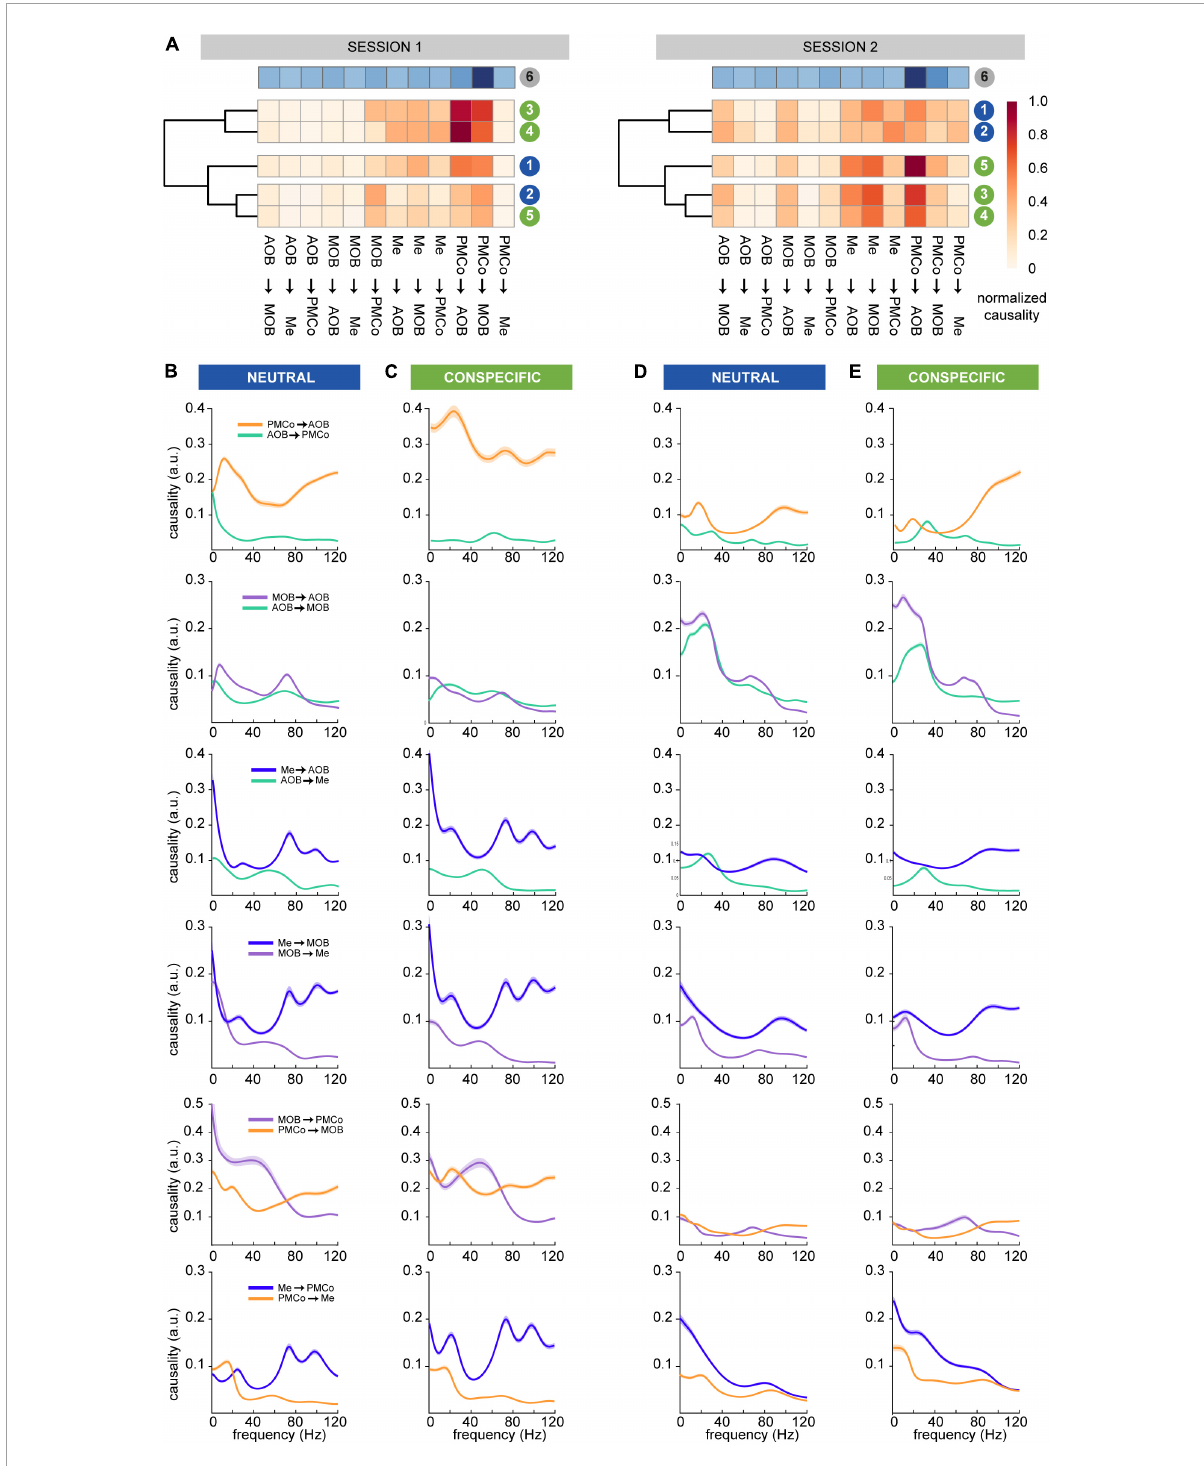
FIGURE4 Granger’s causal analysis in the time and frequency domains. (A) Clustering of the similarity strength (arbitrary units) of the average causal values in the time domain for each stimulus for session 1 (left) and session 2 (right). The neutral stimuli, clean (1) and geraniol scented (2) bedding, in blue; and conspecific, castrated male (3), female (4) and intact male (5) soiled bedding, in green. In the top position, the pattern for non-exploration periods is represented in blues’ colormap, to allow comparison with the clustered patterns. (B) Averaged causal values in the frequency domain for selected pairs of nuclei during session 1 for neutral stimuli; (C) session 1 for conspecific stimuli; (D) session 2 for neutral stimuli; (E) session 2 for conspecific stimuli. (B–E) First row shows PMCo and AOB dynamics, second row MOB and AOB dynamics, third rows Me and AOB dynamics, fourth rows Me and MOB dynamics fifth row MOB and PMCo dunamics and sixth row Me and PMCo